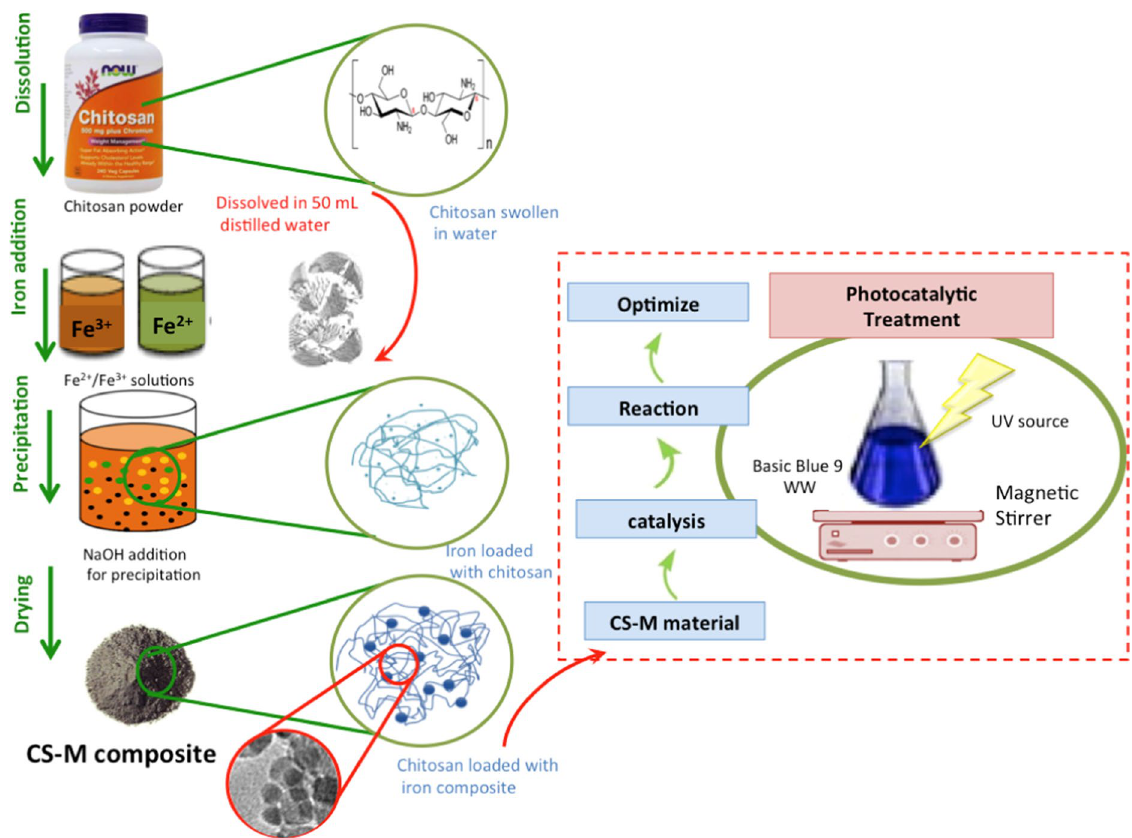
Fig. 1 Graphical representation of the CS-M composite preparation and its use in wastewater oxidation